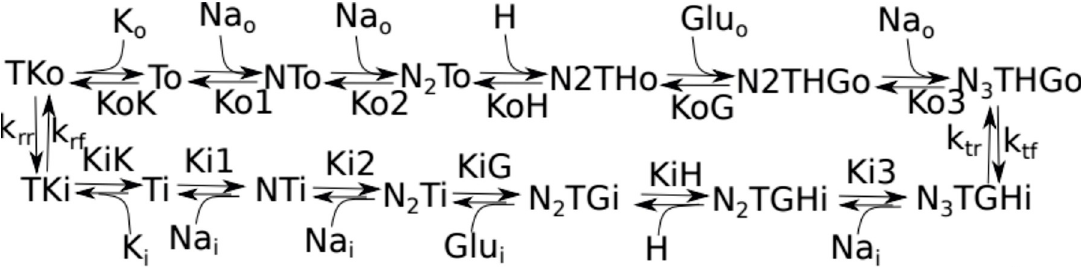
Fig 11. The scheme of glutamate transport implemented in the model. Outside Na+ (Nao) binds to the free transporter in the ‘outer’ configuration (T), accessible for binding outside ions. This binding facilitates the binding of glutamate (Gluo) and then Na + atoms again. The model assumes fast equilibrium in these steps. The transporter changes configuration (T’), facilitating dissociation of all bound Na + ions and glutamate inside cells. K + binding facilitates a switch of the transporter to the outer structure and dissociation of bound K +